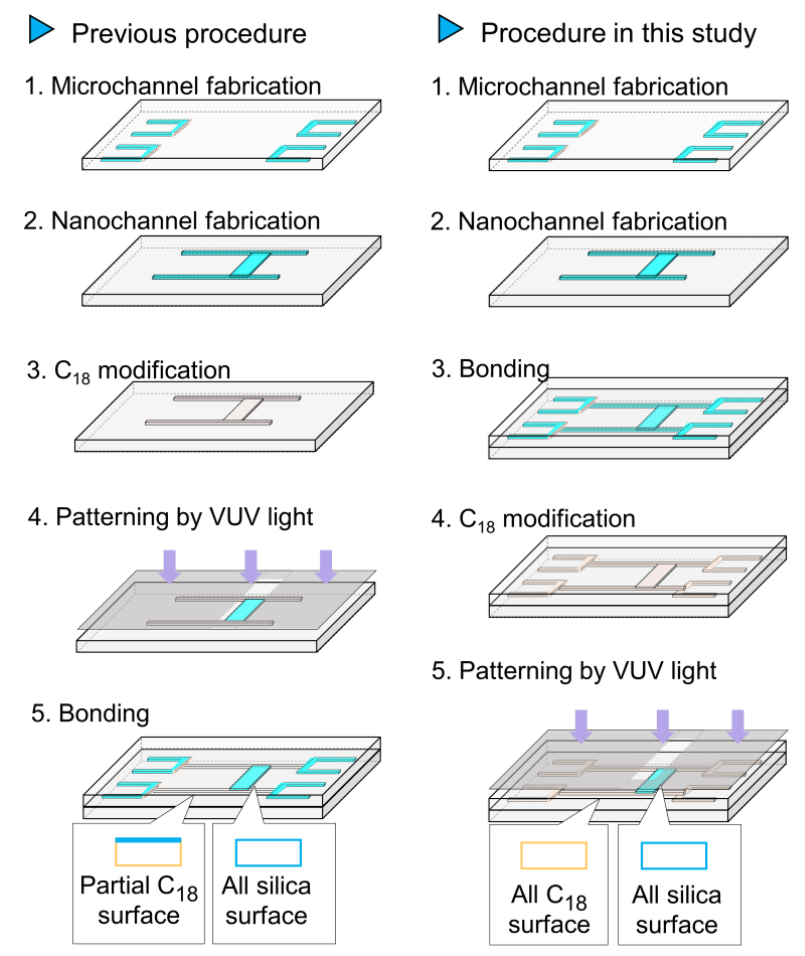
Figure 1. Procedure for nanochannel fabrication and surface patterning.